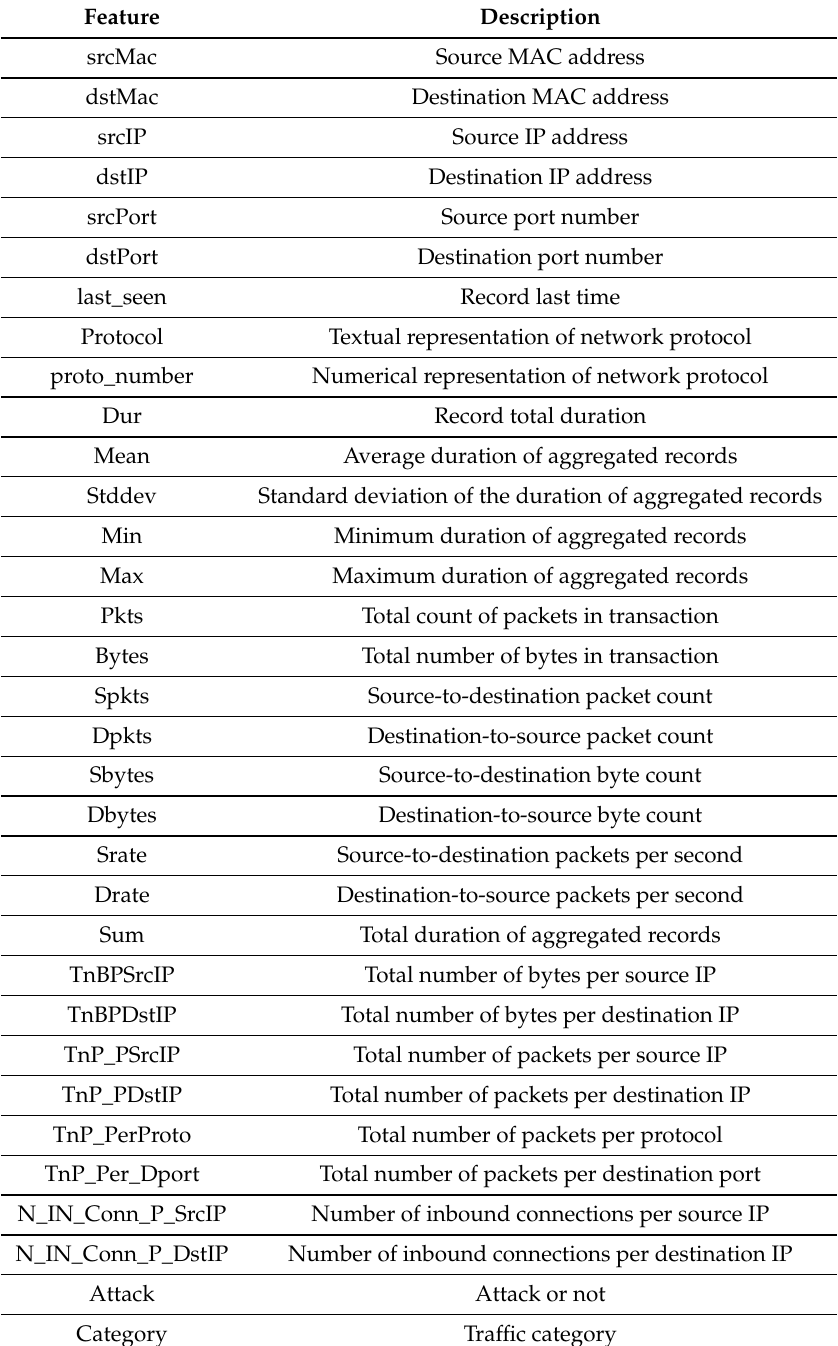
Table 2. Features of the created SDN datasets.